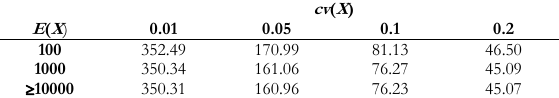
Theoretical values of ARL for the  Ye in Table